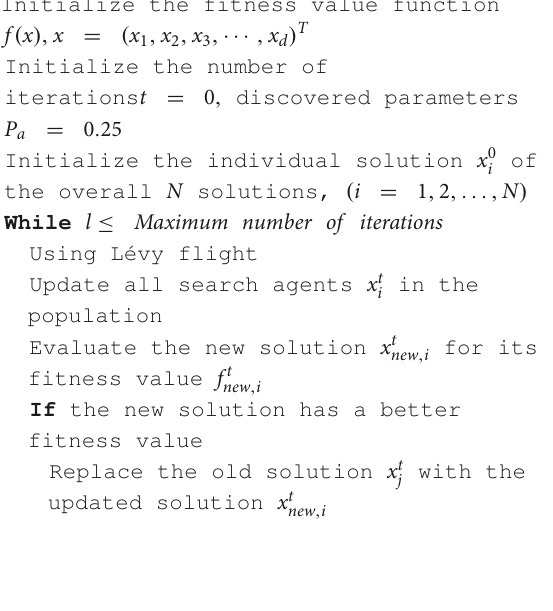
Algorithm 1. Pseudo-code of